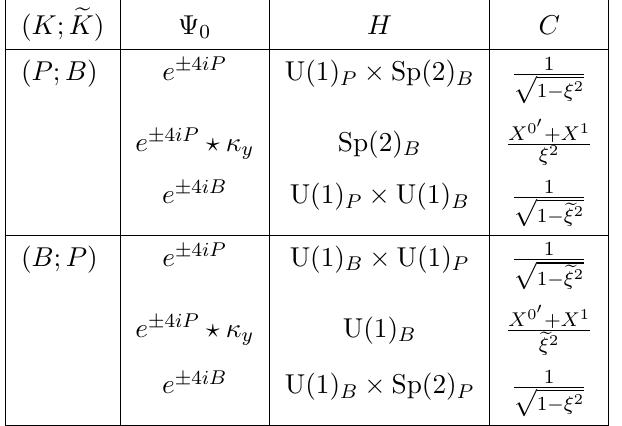
(cid:0)! (cid:0)! K and e K , respectively,